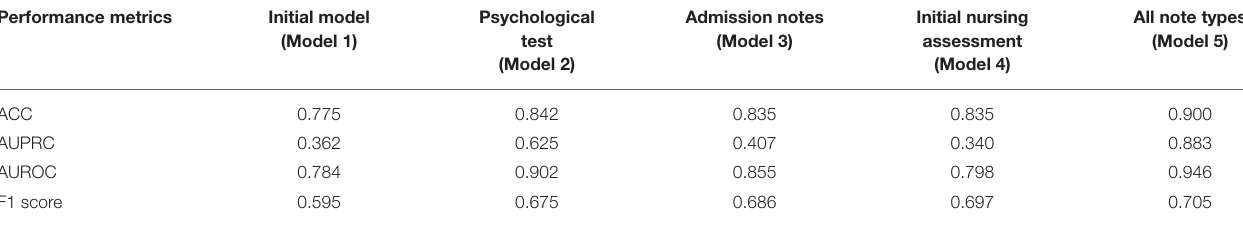
TABLE 3 | Performance results of the initial model and NLP-enriched models using the clinical note. Performance